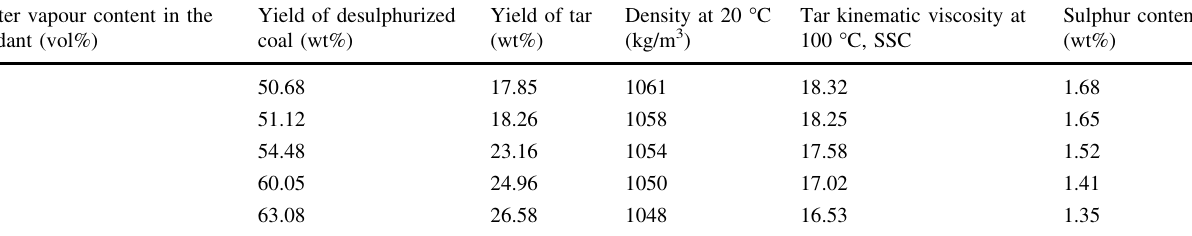
Table 2 Effect of the oxidant composition (other fixed conditions: the temperature—425 (cid:3) C; OFR—2.4 m 3 /(h kg); process duration - 15 min) Water vapour content in the oxidant (vol%)